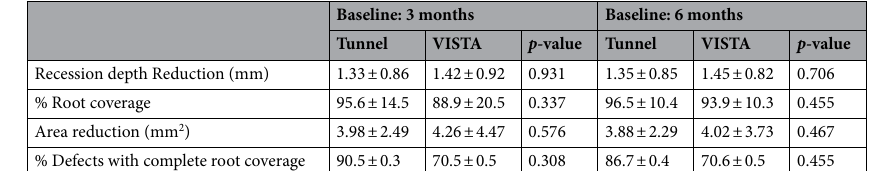
Table 4. Comparison of the Tunnel and VISTA Groups regarding recession depth reduction, percentage of root coverage, and percentage of defects with complete root coverage, at 3 and 6 months after